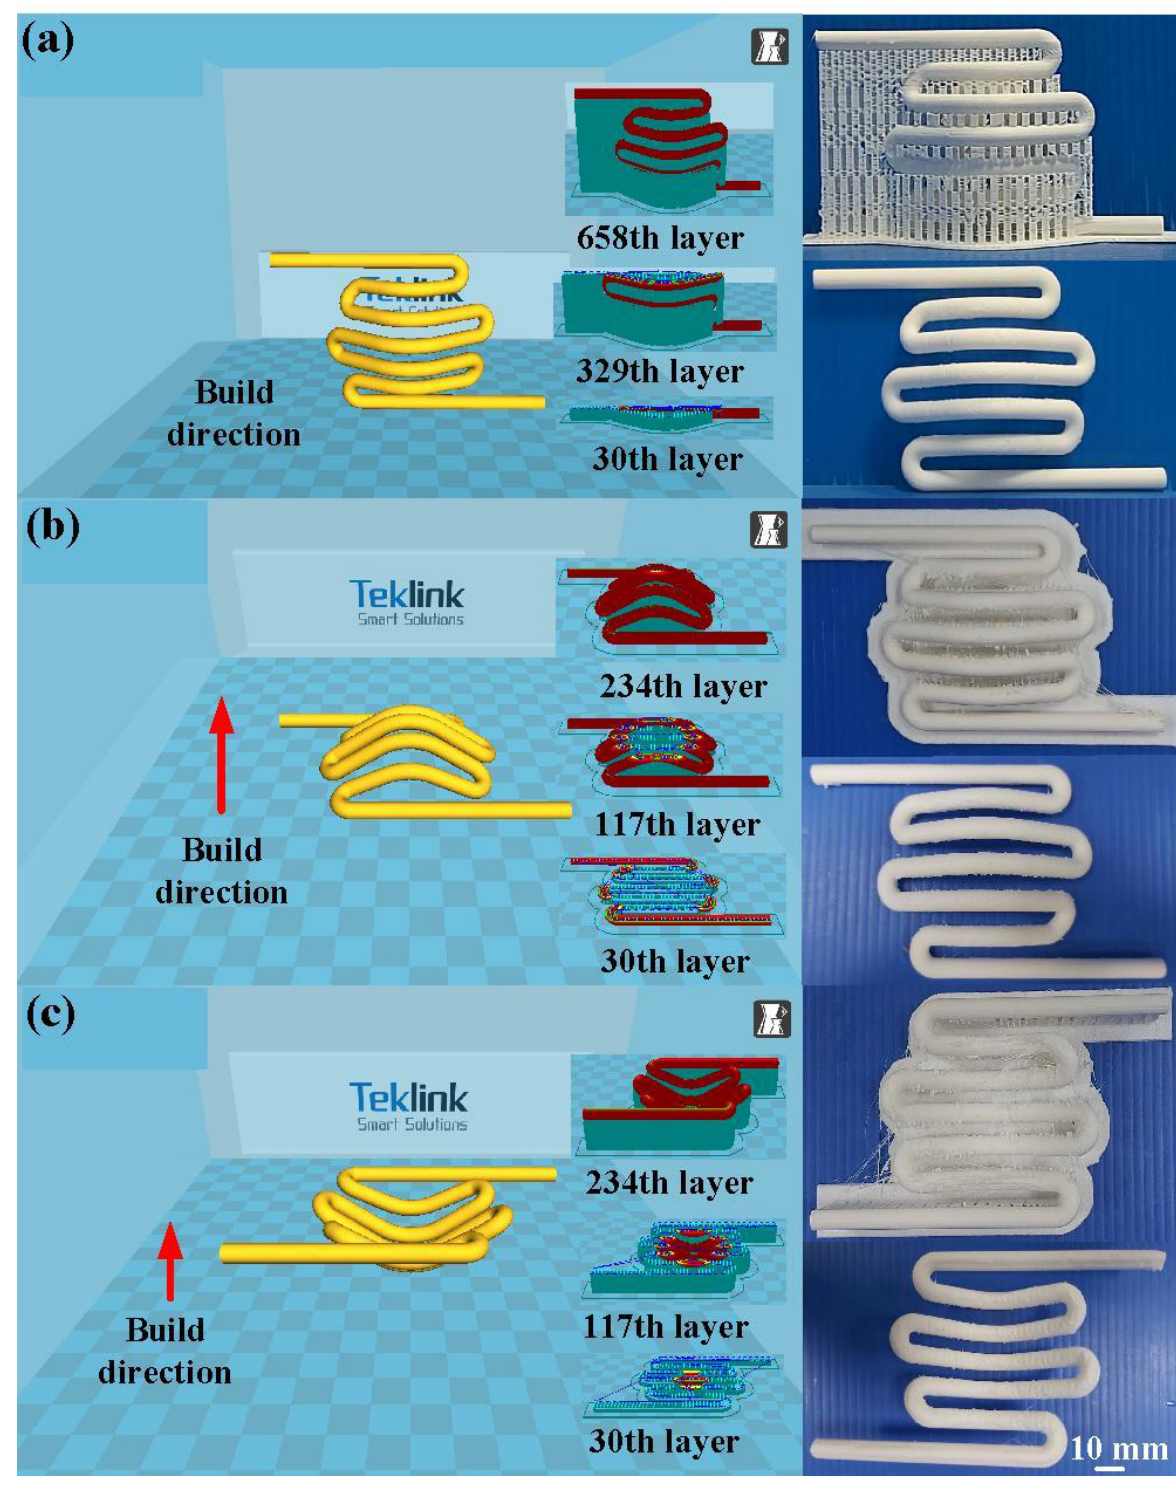
Figure 8. CHC before and after removing support materials using three different build directions: ( a ) vertical, ( b ) horizontal, and ( c ) inverted.